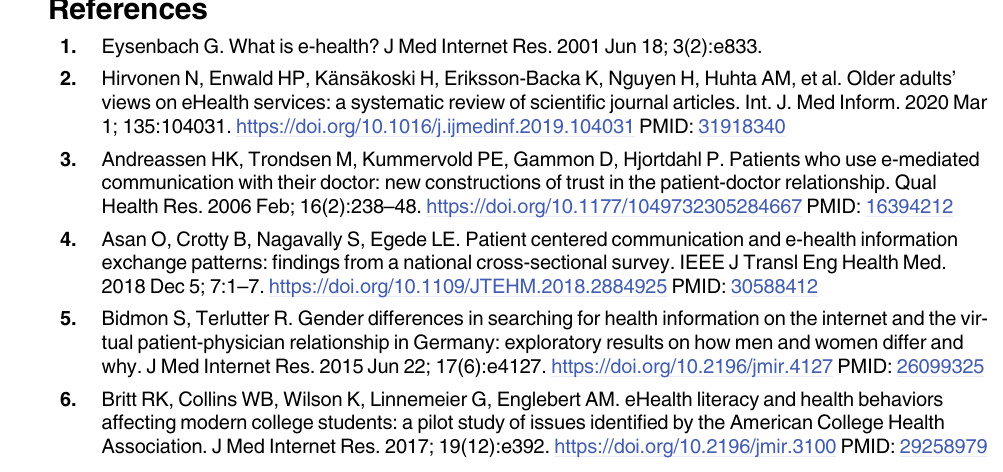
S3 Table. Means of each eHEALS question and the mean eHEALS score of